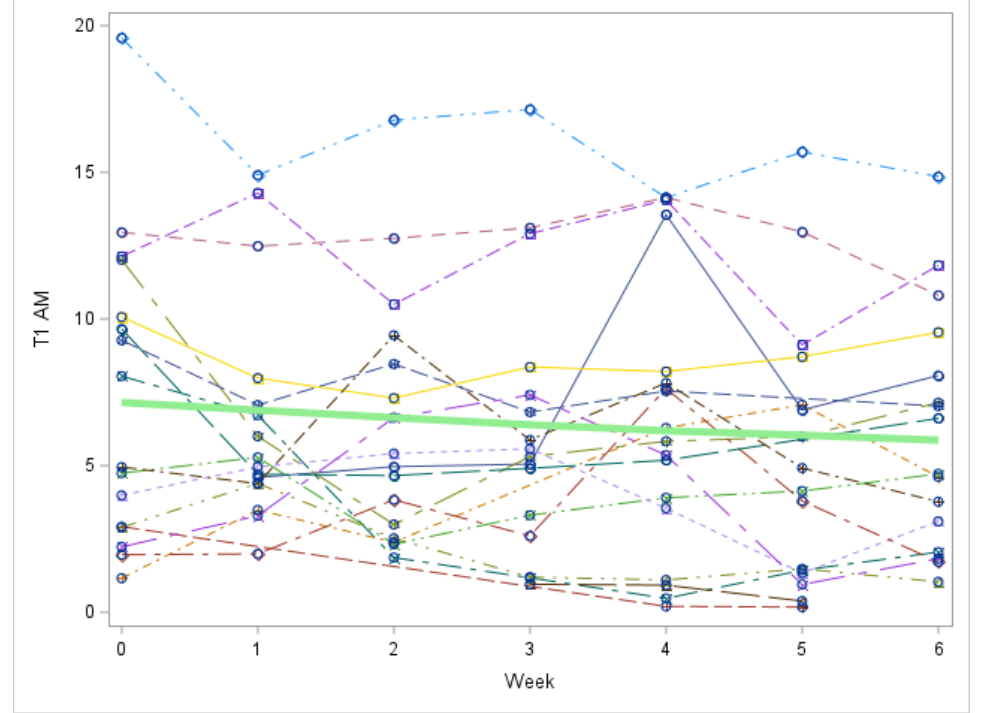
Figure A4. Study 1: 3,5-T2 trend over all hours after LT3 dose (Each individual line represents a participant. The green line represents the mean values for all participants). T2 = 3,5-T2 concentration in nmol/L. There is no significant change in 3,5-T2 over time, p value = 0.1901.